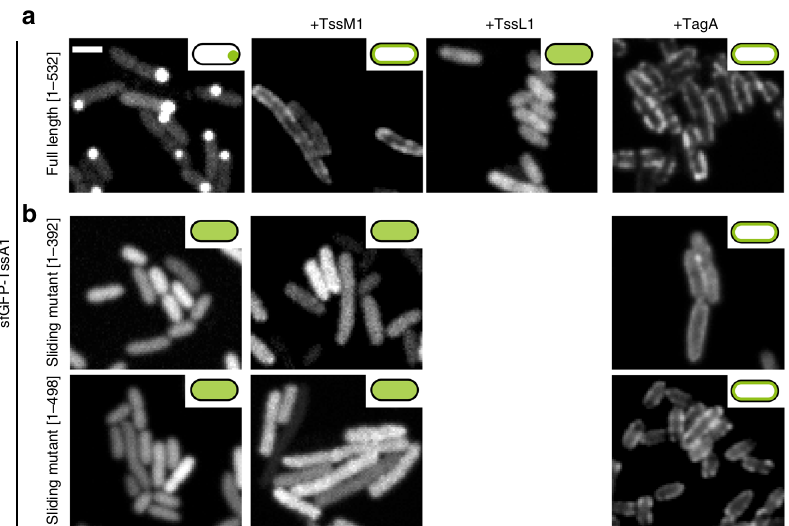
Fig. 6 TssM1 and TagA recruit TssA1 to the cell envelope in vivo. Full length ( a ) and truncated ( b ) sfGFP-tagged TssA1 constructs were expressed either alone or together with TssM1/TssL1/TagA. sfGFP-TssA1[1 – 532] showed strong polar foci that likely represented inclusion bodies, as reported previously 16 . Co-expression of sfGFP-TssA1[1 – 532] with TssM1 or TagA resulted in a patchy signal at the cell envelope, indicating recruitment to the membrane. The TssA1 C-terminus was essential for the TssM1- but not the TagA-dependent membrane recruitment, as the co-expression of sfGFP-TssA1[1 – 392] or TssA1 [1 – 498] with TssM1 showed whole cell fl uorescence. Both TssA1 sliding mutants could localize to the IM in the presence of TagA but a signi fi cant fraction of the labeled proteins was present in the cytoplasm, indicating a lower af fi nity of the interaction. TssL1 failed to recruit sfGFP-TssA1[1 – 532] to the membrane. Cellular localization of relevant sfGFP-TssA1 constructs is shown in schematic diagrams. Scale bar: 2 μ m